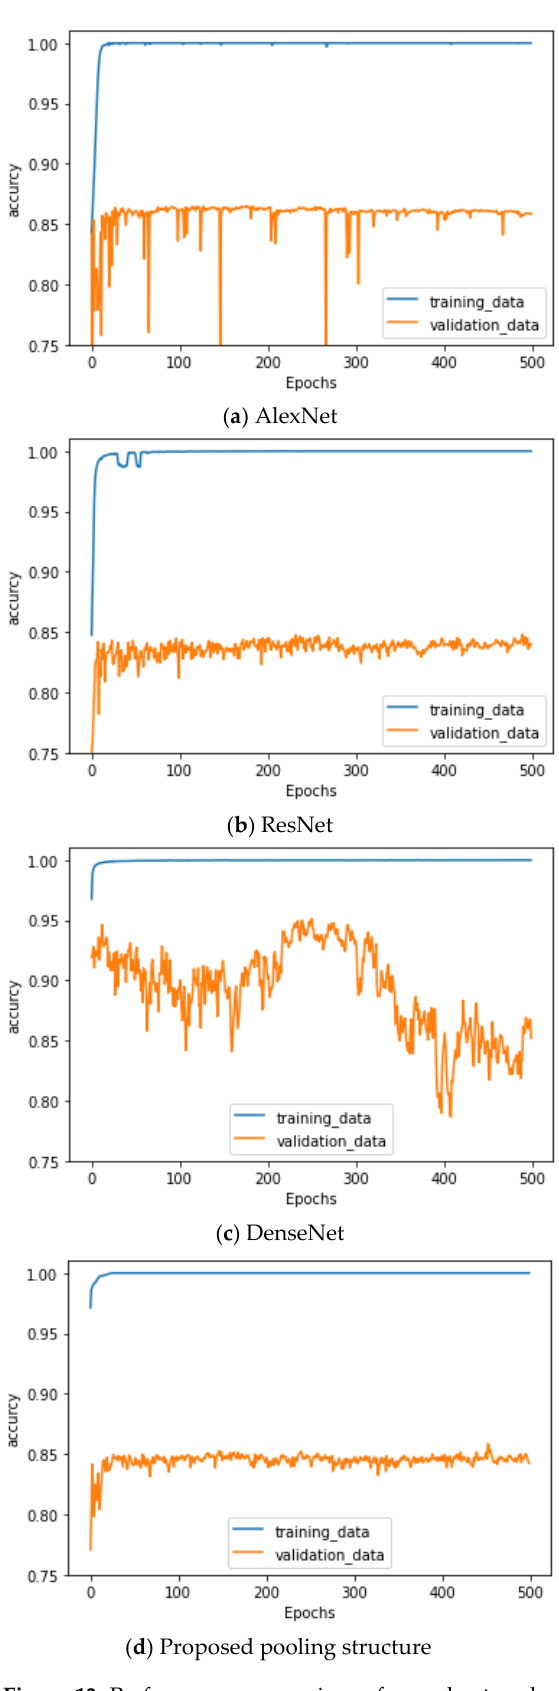
Figure 13. Performance comparison of neural network models using crawling data.